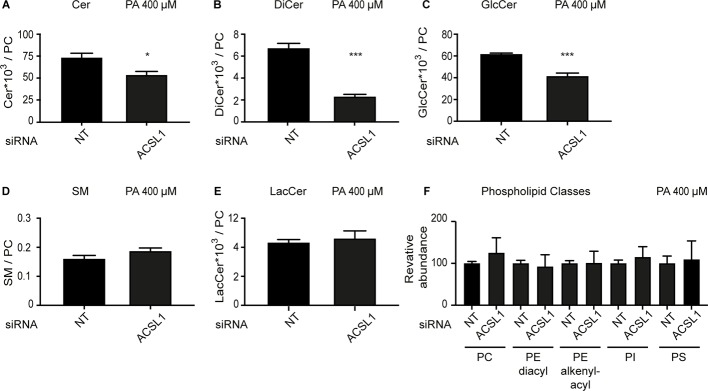
ACSL1 siRNA alters the levels of some sphingolipids in HEK293 cells challenged with palmitate.(A–E) Abundance of the indicated sphingolipids relative to PCs in HEK293 cells treated with non-target (NT) or ACSL1 siRNA and challenged with 400 μM palmitate. Cer: ceramides; DiCer: dihydroxyceramides; GlcCer: glucosylceramides; SM: sphingomyelins; LacCer: lactosylceramides. (F) Relative abundance of several phospholipid classes between NT and ACSL1 siRNA-treated cells challenged with 400 μM palmitate; abbreviations are as in (A–E), with the addition of phosphatidylinositols (PI) and phosphatidylserines (PS). Statistically significant differences are indicated, where *: p<0.05 and ***: p<0.001.Figure 6—figure supplement 1—source data 1.Lipidomics data for panels A to E.Figure 6—figure supplement 1—source data 2.Lipidomics data for panel F.